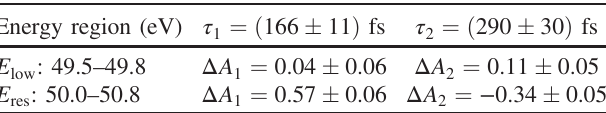
TABLE I. Results of the global exponential fit [Eq. (1)] to the data. Energy region (eV) τ 1 ¼ ð 166 (cid:3) 11 Þ fs τ 2 ¼ ð 290 (cid:3) 30 Þ fs E : 49.5 – 49.8 Δ A 1 ¼ 0 . 04 (cid:3) 0 . 06 low